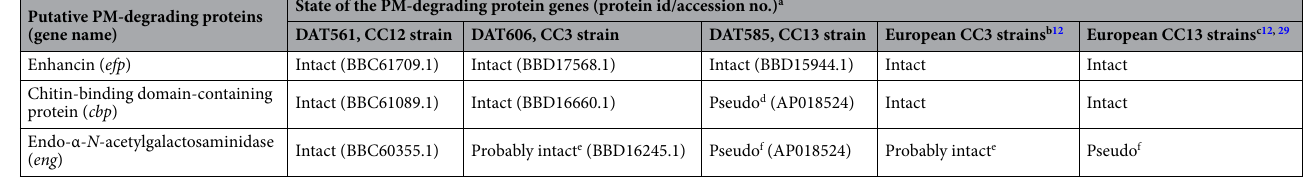
Table 1. State of genes encoding putative PM-degrading proteins of M. plutonius . a CC, clonal complex. b Strains 764-5B, 765-6B, 49.3, S1, 60, 21.1, B5, H6 and L9. c Strains ATCC 35311 (LMG 20360), 119, 90.0 and 82. d Chitin-binding domain-containing protein of DAT585 was truncated due to a 193-bp deletion. e Endo-α- N -acetylgalactosaminidases of CC3 strains were 30 amino acids shorter than that of DAT561 due to a 90-bp deletion. f Endo-α- N -acetylgalactosaminidases of CC13 strains were truncated due to nonsense